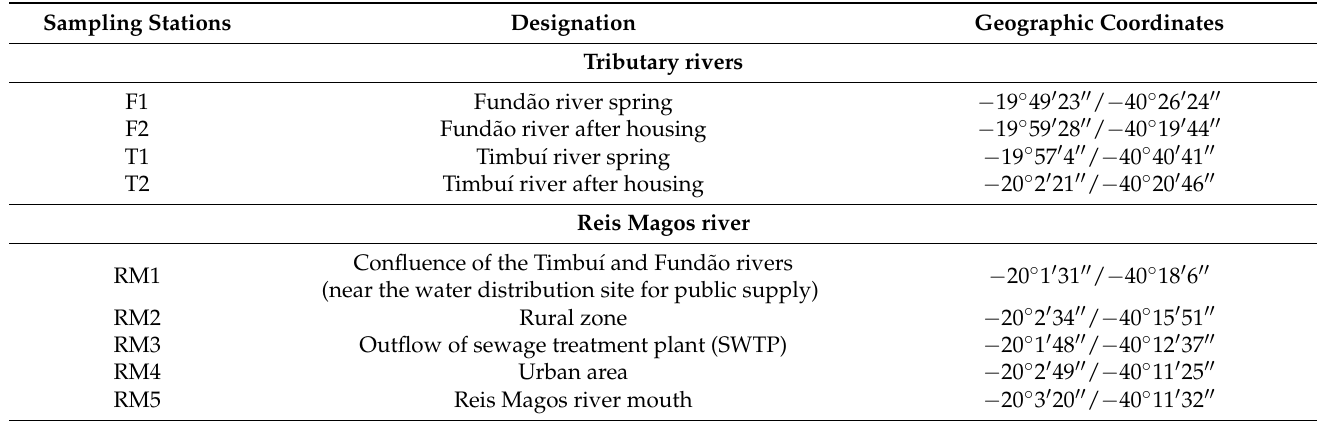
Table 1. Geographical coordinates of sampling stations along the